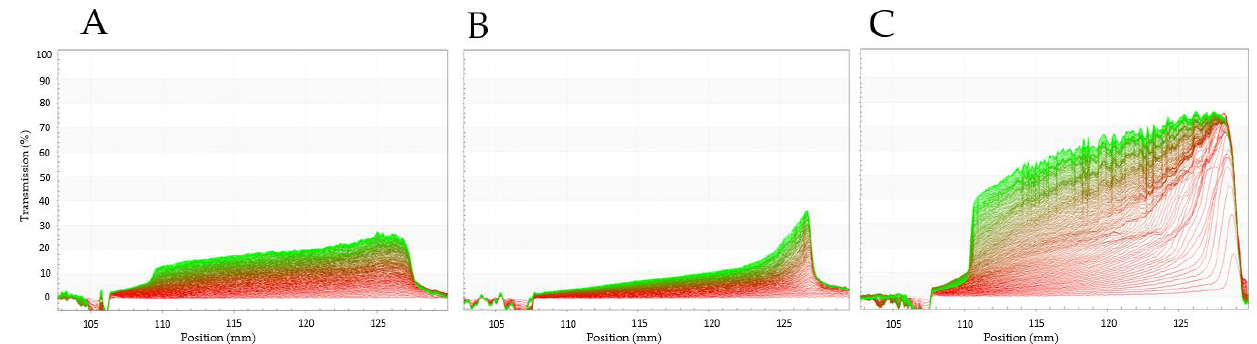
Figure 6. Light transmission profiles of pea ( A ), soy ( B ) and EverPro ( C ), where the left-hand side of the curves represents the top of the measurement cell.